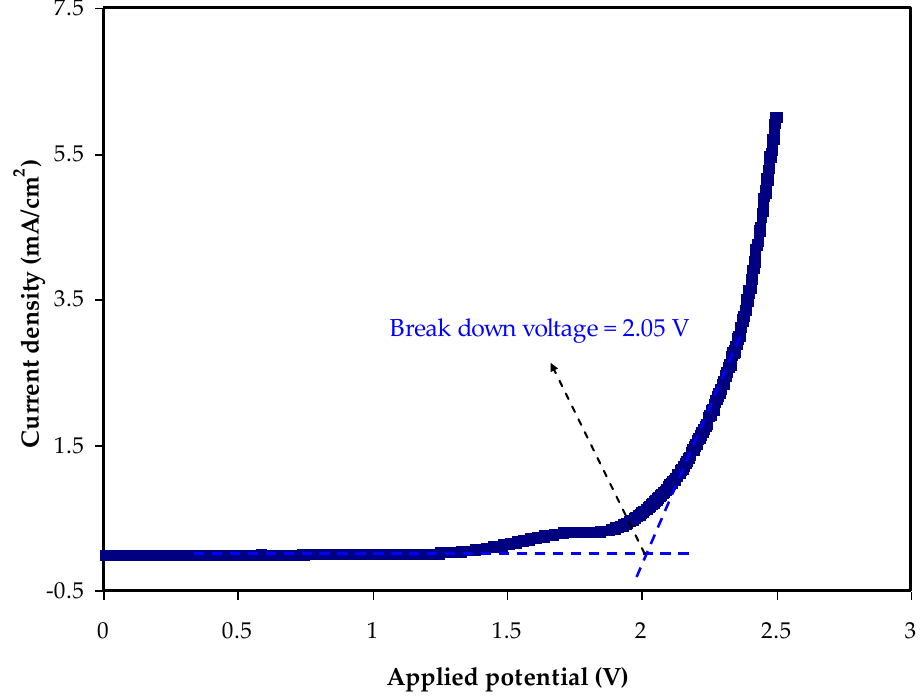
Figure 3. LSV plot for the MC:DN:NH 4 SCN:Gly:Zn electrolyte.